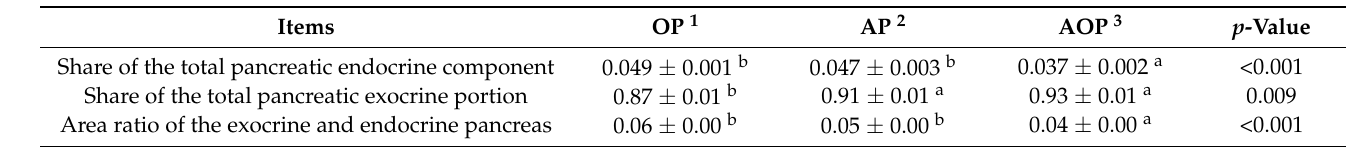
Table 3. Effect of diets with different forage sources on the share of exocrine and endocrine parts of the total pancreatic area in preweaning yak calves.